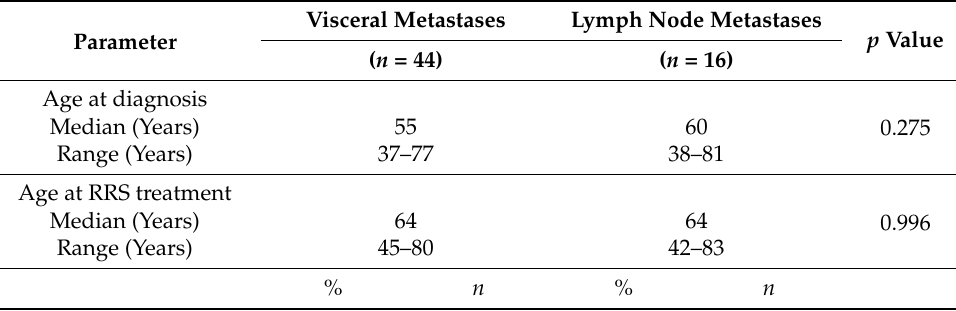
Table 1. Patient